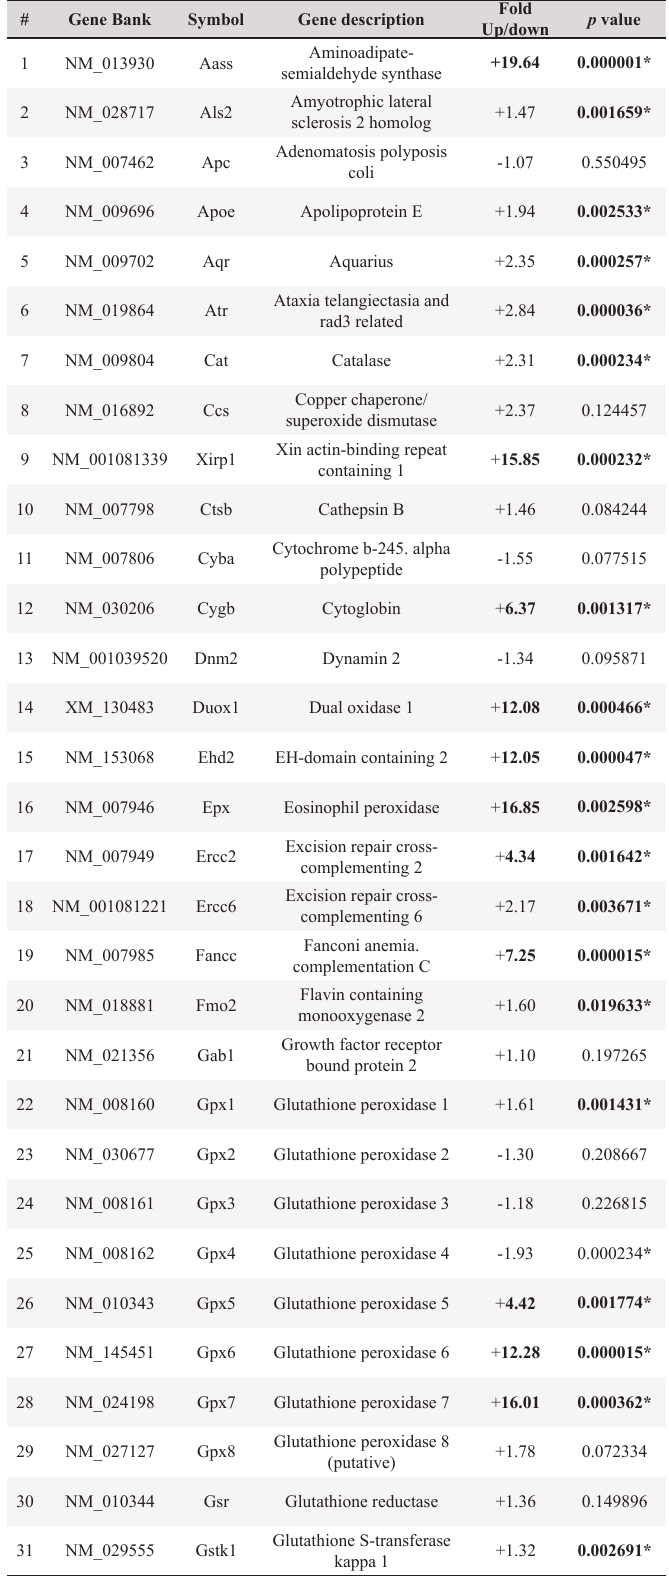
TABLE 1 - Alphabetical sequence of genes investigated and the fold up (+) or down (-) regulation